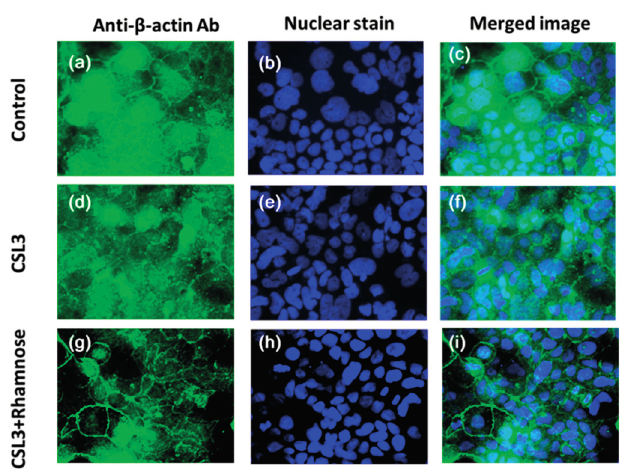
Figure 7. Effect of CSL3 on the distribution of β -actin in Caco-2 cell monolayers. The cells were incubated in HBSS for 2 h in the absence ( a , b , c ) or presence of CSL3 (100 µg/mL) ( d , e , f ). After incubation with CSL3, the cells were incubated with 10 mM L -rhamnose for another 1 h ( g , h , i ). The fluorescence images were examined by a fluorescence